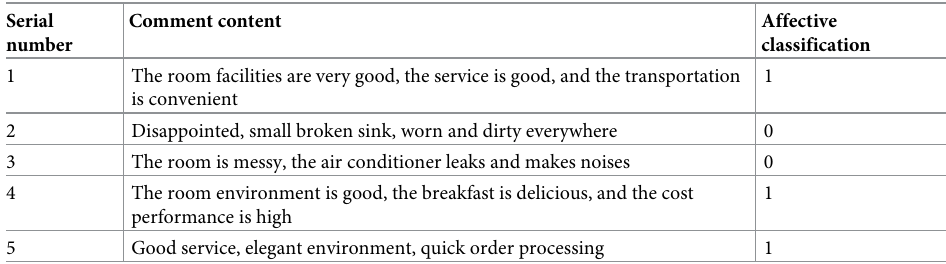
Table 1. Word breakdown of hotel